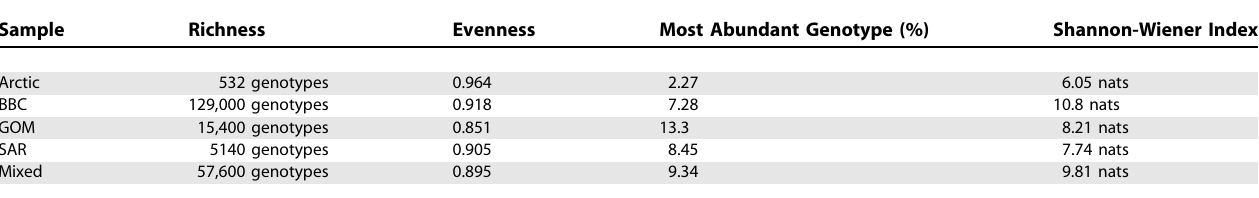
Table 3. Viral Assemblage Structure Predicted from Assembly of Metagenomic Sequences